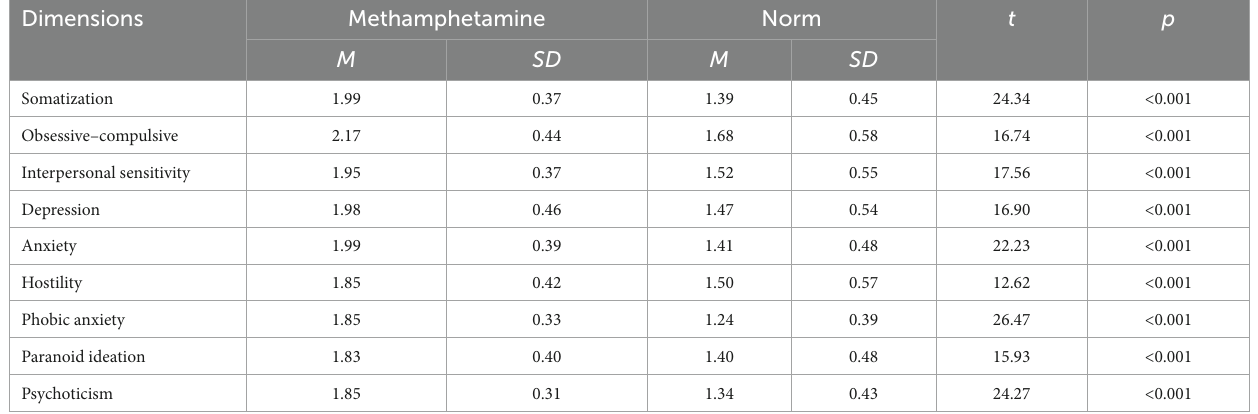
TABLE 2 Respondents’ scores in nine dimensions of SCL-90 ( N =